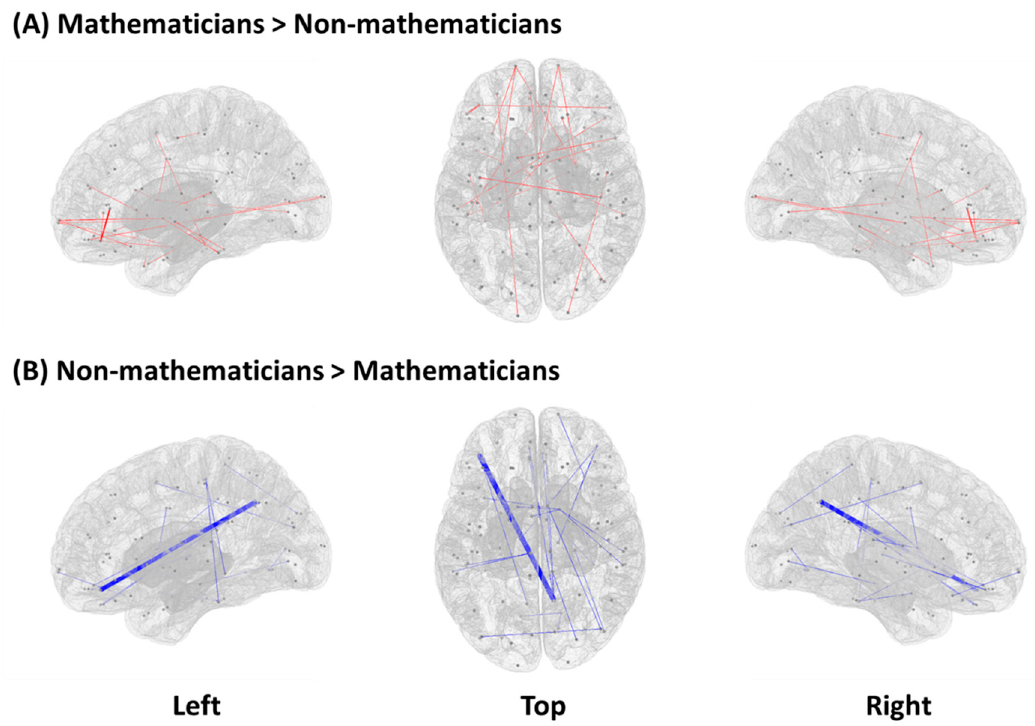
Figure 1. Significant differences between mathematicians and non-mathematicians in terms of functional connectivity (independent permutation t -test, p < 0.01). ( A ) Increased functional connectivity in mathematicians compared to non-mathematicians. ( B ) Increased functional connectivity in non-mathematicians compared to mathematicians. Line width is defined based on inverted p -values (1/ p ). Dots indicate 22 pairs of ROIs for mathematicians (A) and 24 pairs of ROIs for non-mathematicians (B). Left and right views of ROI pairs show sagittal images and top view demonstrates an axial image.